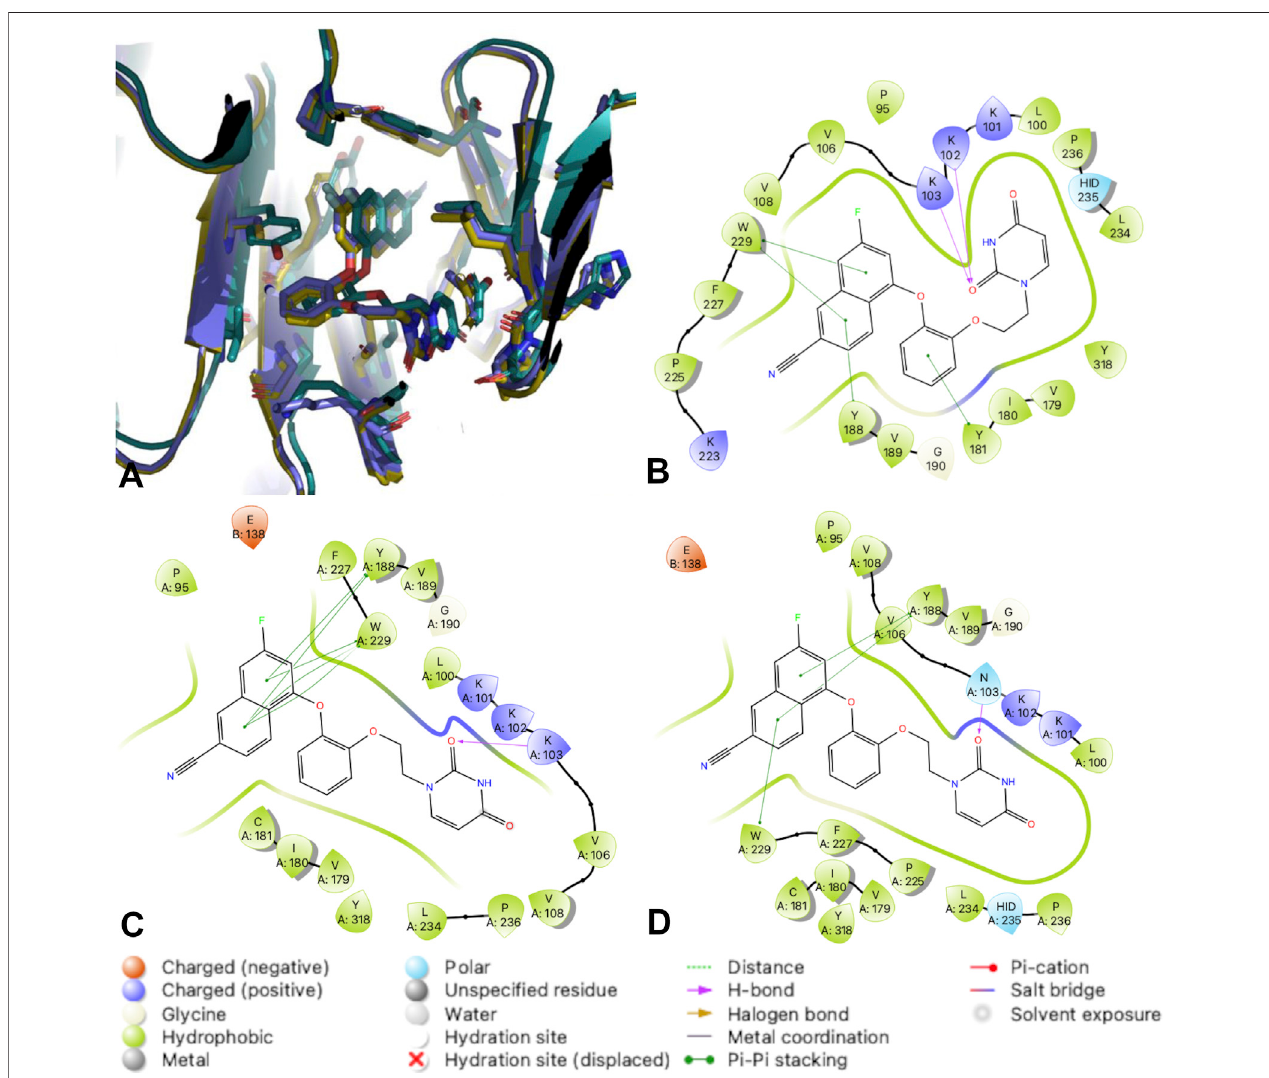
FIGURE 6 | RT complexes with compound 3. (A) An overlay of RT (WT) (teal); RT (Y181C) (lavender); and RT (K103N/Y181C) (gold) in complex with compound 3. (B) 2DinteractiondiagramforRT(WT)incomplexwithcompound3. (C) 2DinteractiondiagramforRT(Y181C)incomplexwithcompound3. (D) 2Dinteractiondiagram for RT (K103N/Y181C) in complex with compound 3. Hydrogen bonds are represented by purple arrows; π - π interactions are represented by green lines between aromatic rings and residues; van der Waals contacts are made between all listed residues within a radius of 4 Å. The key provided speci fi es residue type, water molecules, and